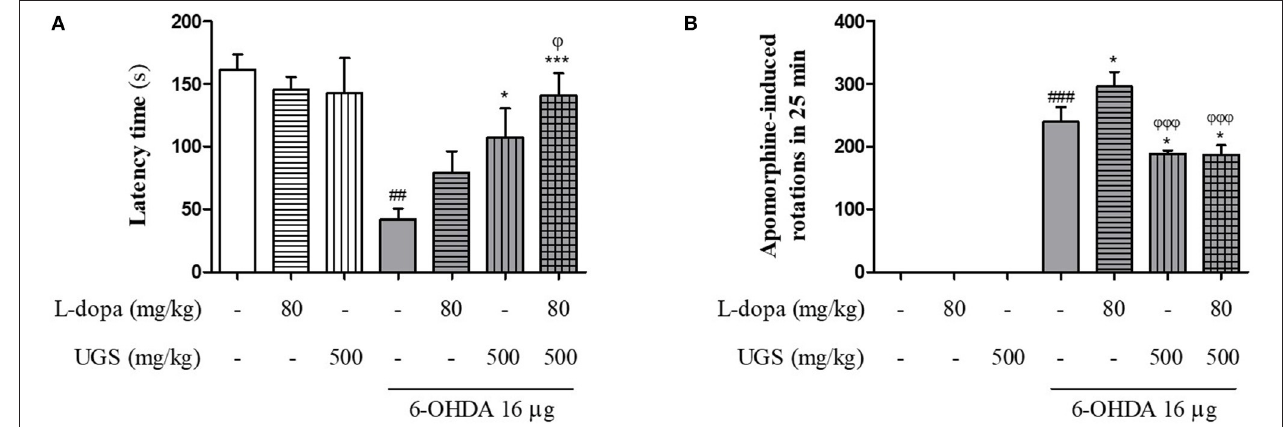
FIGURE 2 | UGS attenuated 6-OHDA-induced motor dysfunctions when co-treated with L-dopa. To evaluate the passive motor function, rotarod test was assessed (A) . For hemi-parkinsonian model, it can evaluate the effect of dopamine function via apomorphine-induced rotation tests (B) . Values are given as the mean ± S.E.M. ( N = 8). The significance of differences was analyzed by one-way ANOVA followed by Bonferroni’s Multiple Comparison Test: ## p < 0.01 and ### p < 0.001; mean values were significantly different from the sham group. * p < 0.05 and *** p < 0.001; mean values were significantly different from the 6-OHDA group. φ p < 0.05 and φφφ p < 0.001; mean values were significantly different from the 6-OHDA + L-dopa